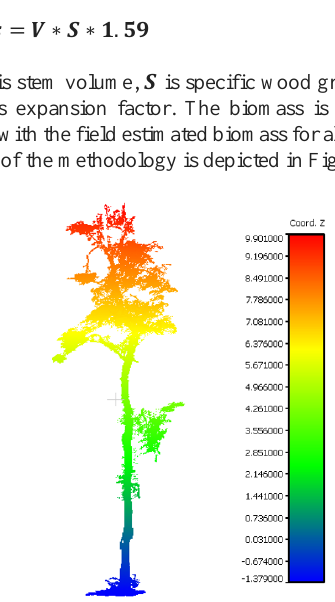
Figure 3 : Individual tree extraction from TLS